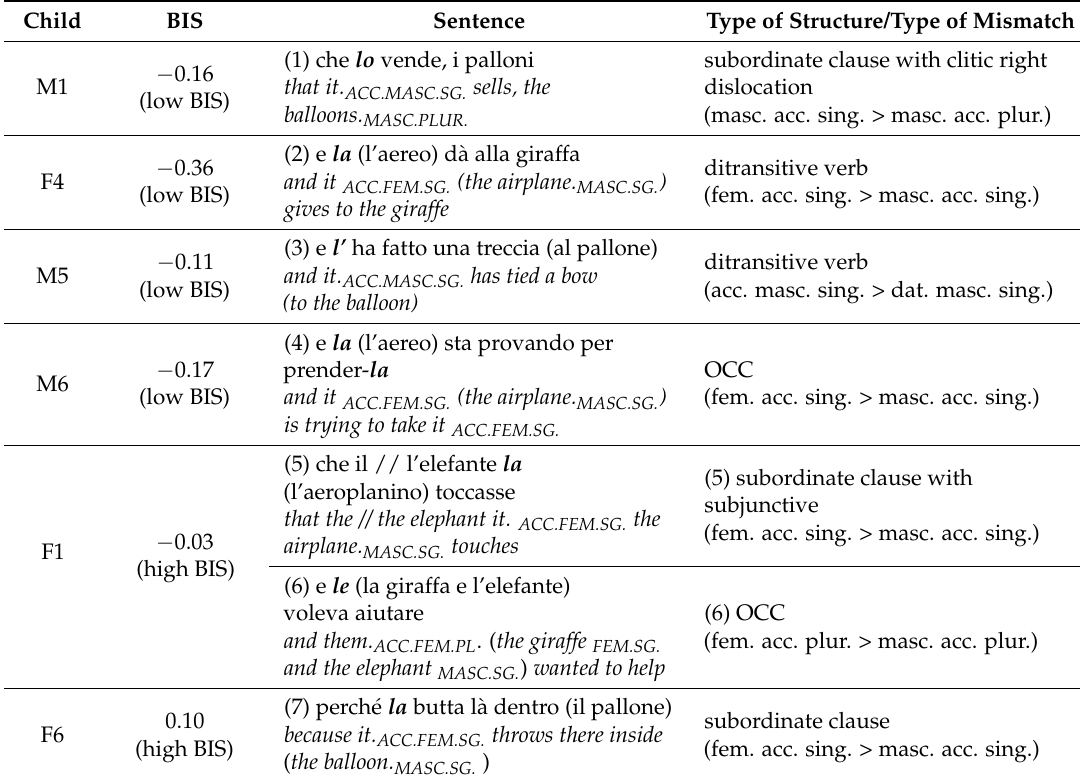
Table 8. Cases of agreement mismatches between a clitic and its corresponding referent, which occur in the narratives. The first column indicates the subject that produced the sentence, the second her Bilingual Index Score, and the fourth the type of structure in which the agreement mismatch appears, together with the type of agreement mismatch (gender, number, case). The symbol ‘>’ indicates ‘instead